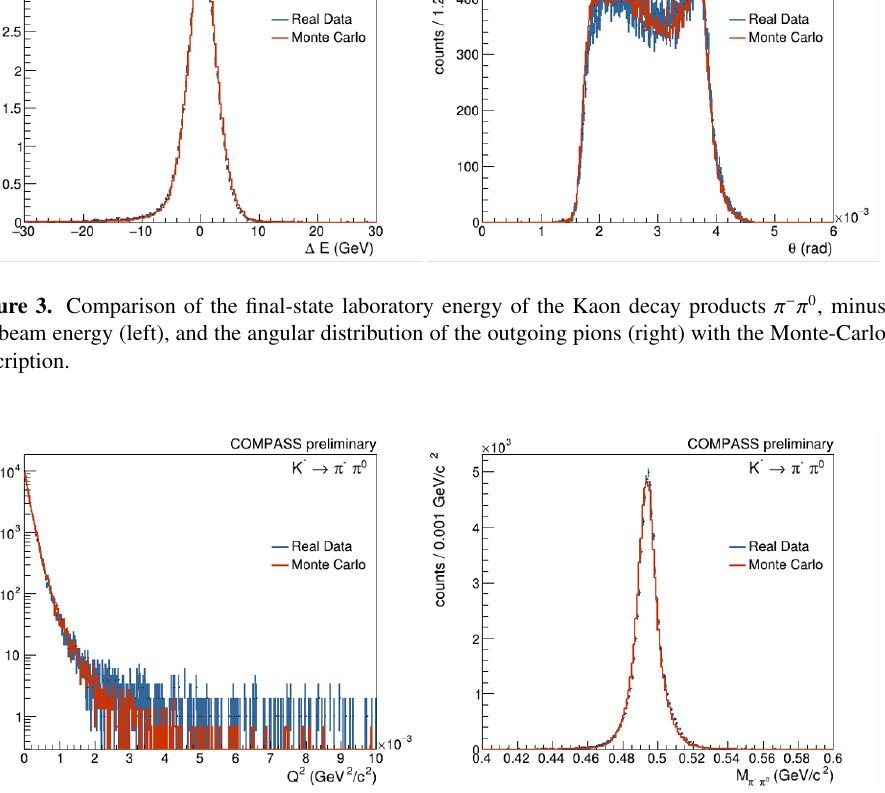
Figure 4. Comparison of the momentum balance in the Kaon decay, reconstructing a hypothetical momentum transfer, which should be zero for infinitely high detector resolution (right), and the invariant mass of the two-pion final-state system (right), with the Monte-Carlo